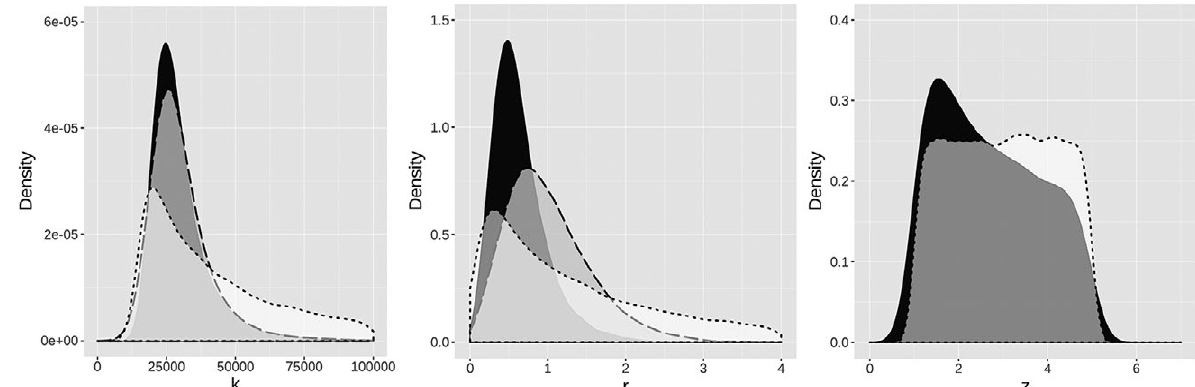
6. – Posterior distribution for the Pella-Tomlinson (dark grey, solid line), Schaeffer (light grey, dashed line) and priors (white, dotted line) for the Bayesian state-space surplus production model parameters. K, support capacity; r, intrinsic growth rate; z, shape parameter (Pella-Tomlinson only). Table 3. – Posterior mean, standard deviation and selected percentiles of parameters and management reference points for the Bayesian state- space surplus production models. Model